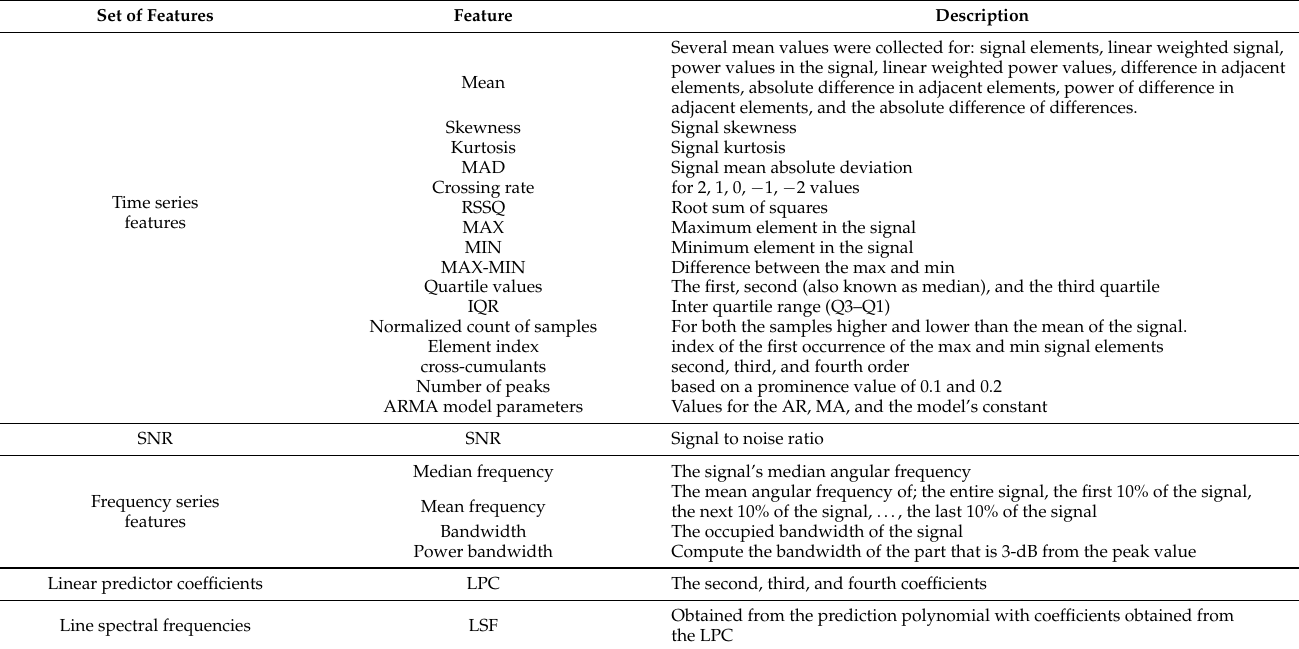
Table 3. Extracted